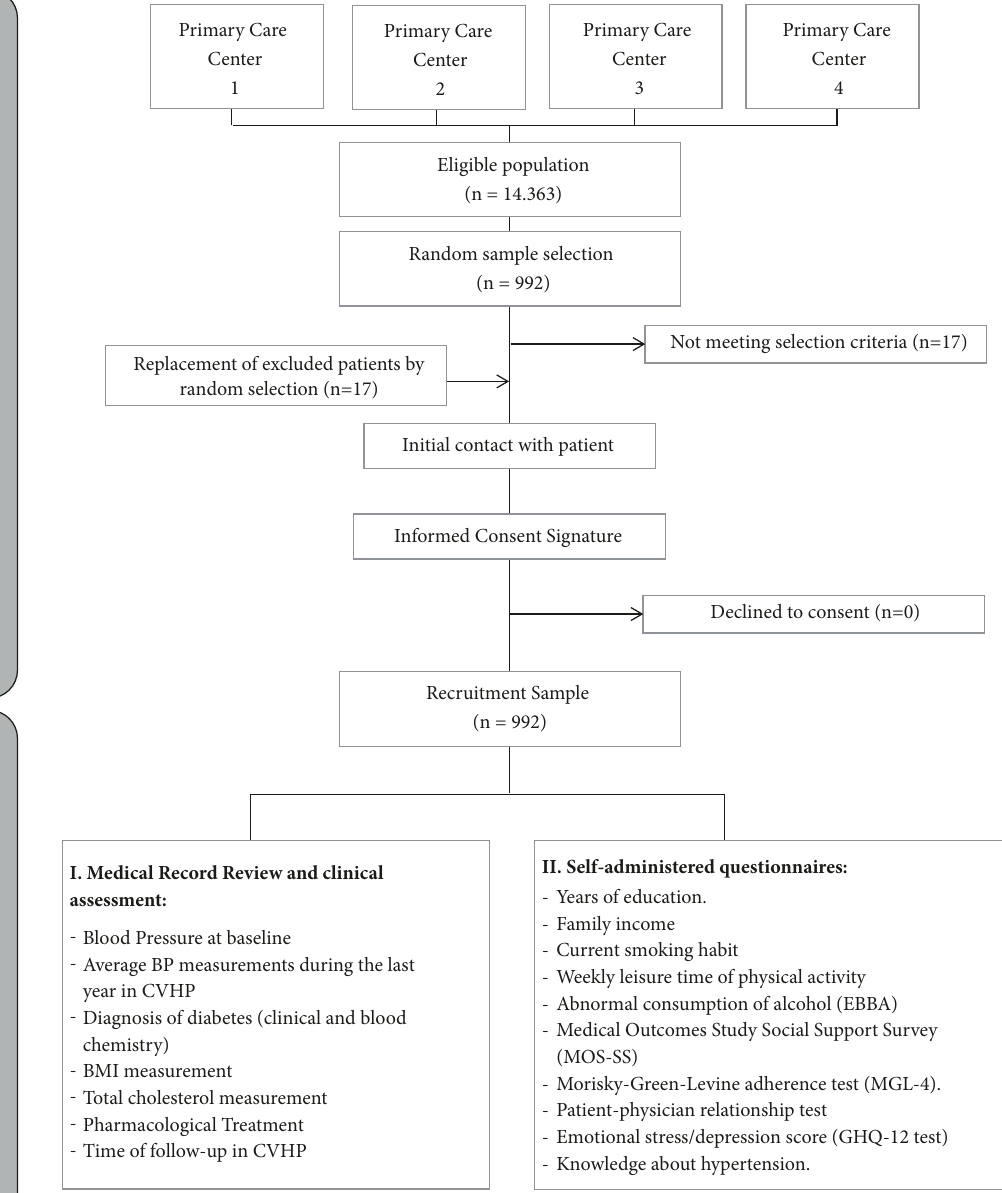
person). Low education corresponded to < than 8 years of